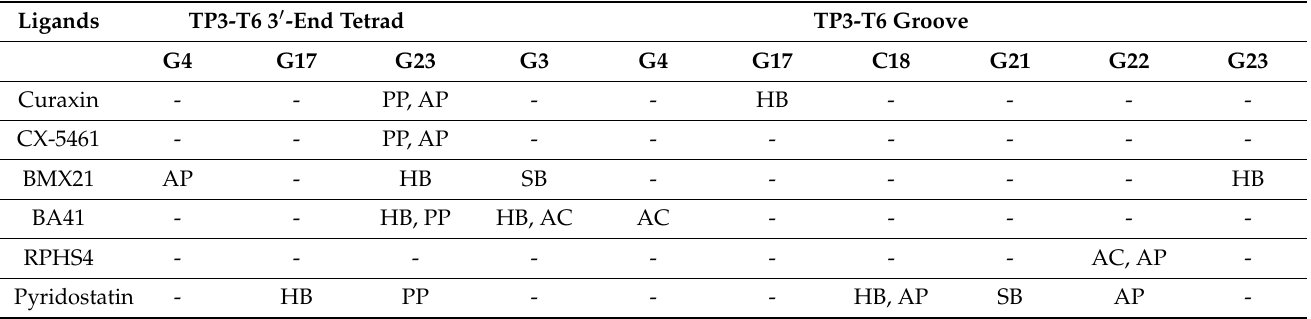
Table 1. Table summarizing the main interactions observed in the TP3-T6/Ligands complexes as obtained by molecular modeling. The table shows the nucleotides involved in the interactions to- gether with the type of interactions.